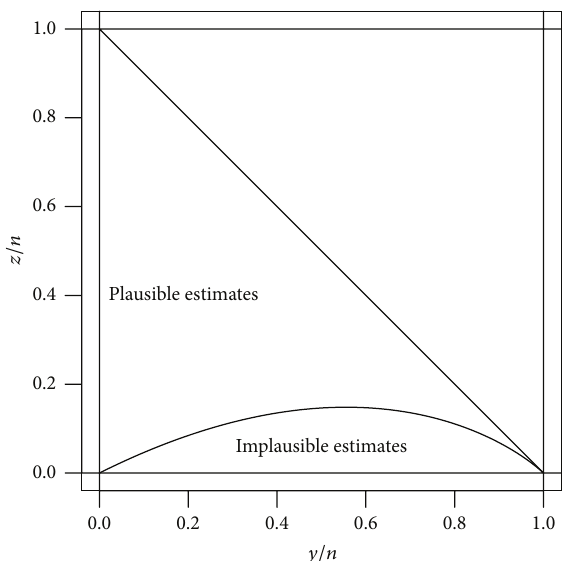
Figure 2: “Plausible” and “implausible” regions for the estimate of 𝛽 through the method of proportion.